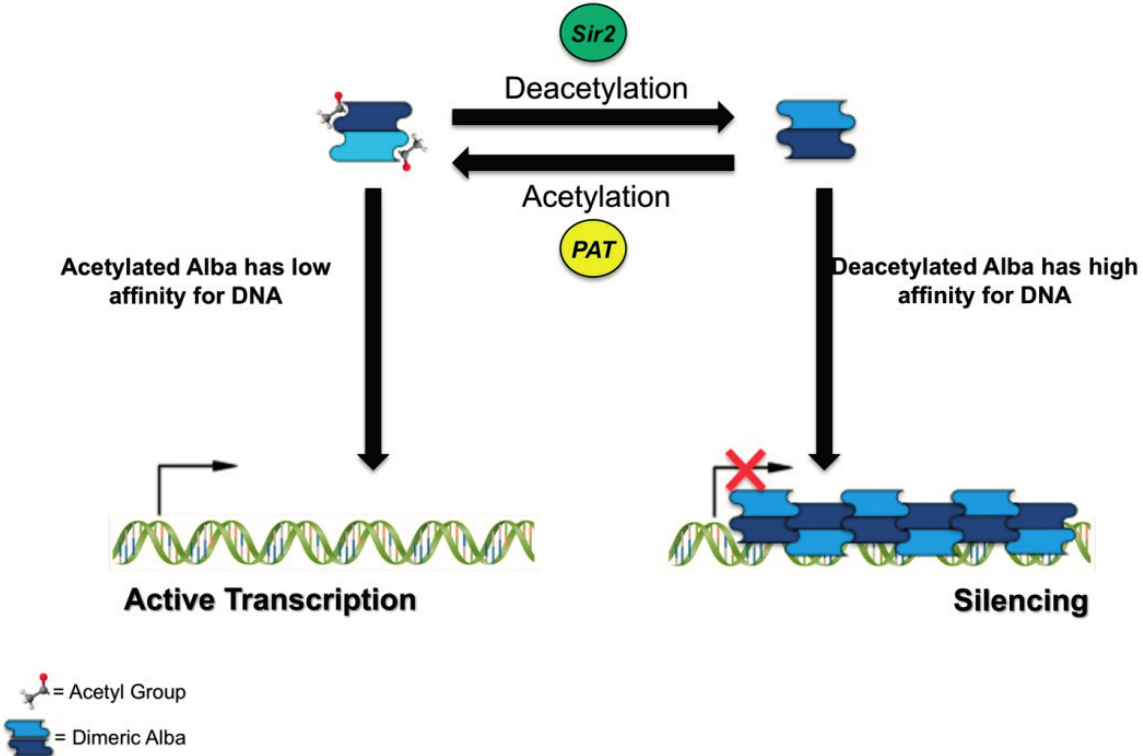
Figure 2. Diagram showing a model for the post-translational regulation of Alba and its effect on